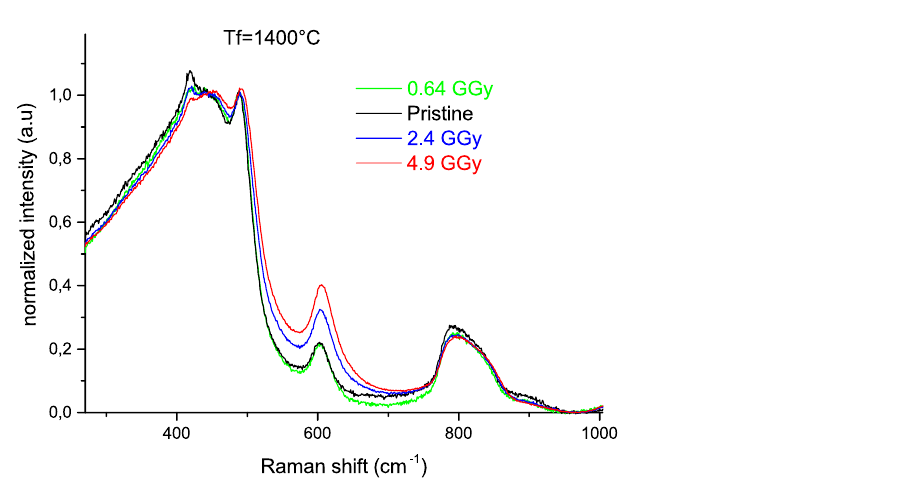
Figure 5. Raman spectra evolution with the integrated dose of (T f = 1400 °C) samples.